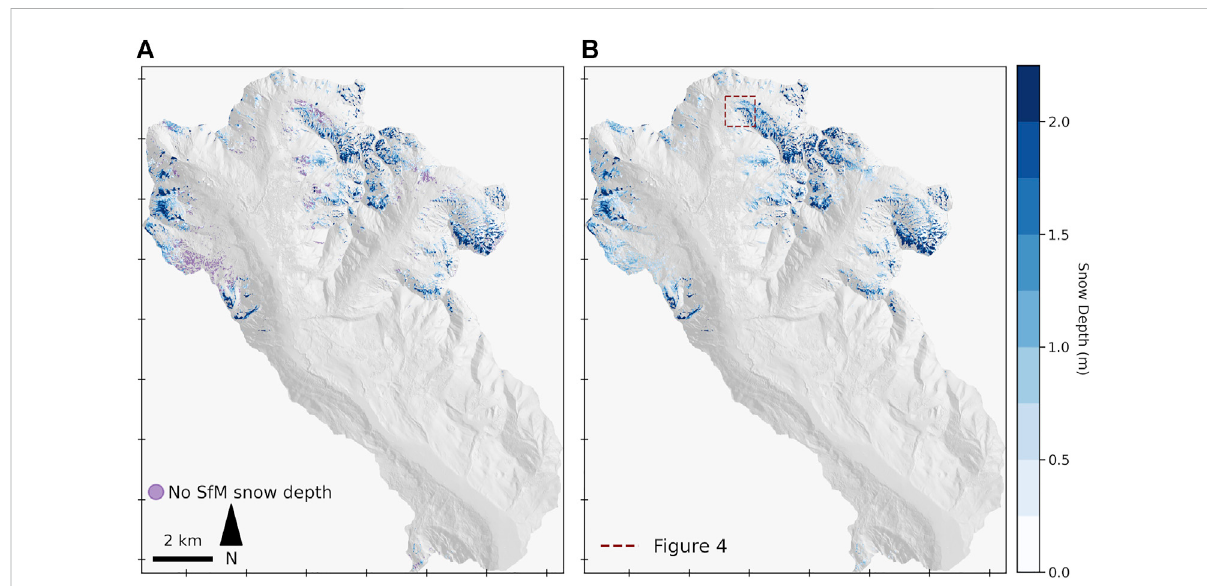
FIGURE 3 Overview ofreconstructedsnow depth bySfM (A) , with ASOsnow depth mapshown on theright (B) at3 mresolution.Areaswithunsuccessful SfMretrievals(purple)coincidedwithsurfacesclassi fi edasvegetationorshallowsnowdepthvalues( < 1 m)byASO.Thesnowdepthpatternbetween the two products showed good agreement over the overlapping area. The red dashed box shows the location of the comparison in Figure 4.